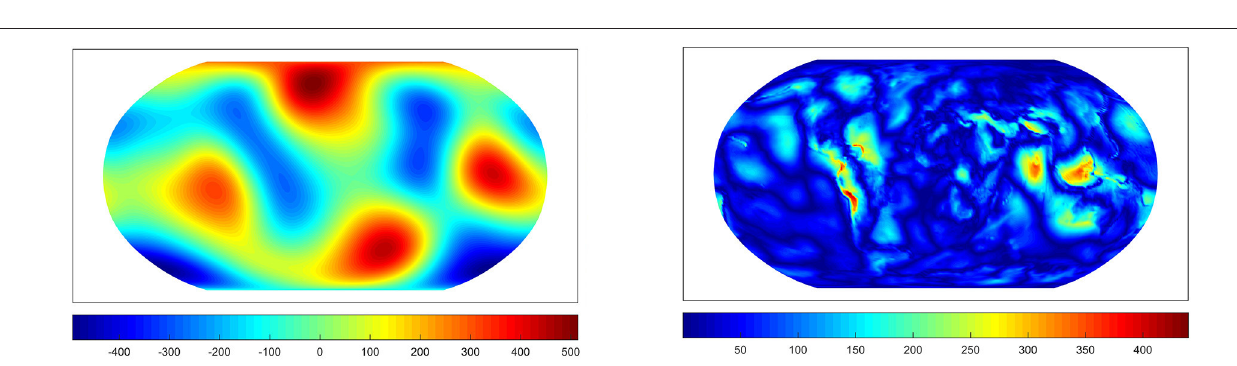
FIGURE 15 | The approximation from the ROFMP for the parameter chosen by the GML (Left) and the difference to the EGM2008 up to degree 100 (Right) . Values in m 2 / s 2 . The inefficiency amounts to